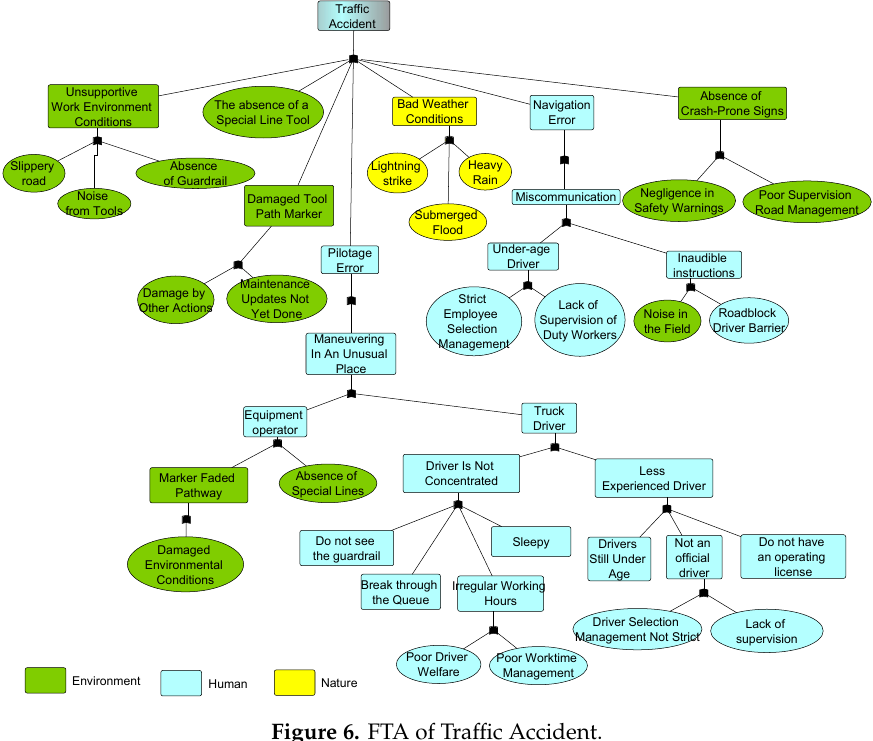
Figure 6. FTA of Traffic Accident.